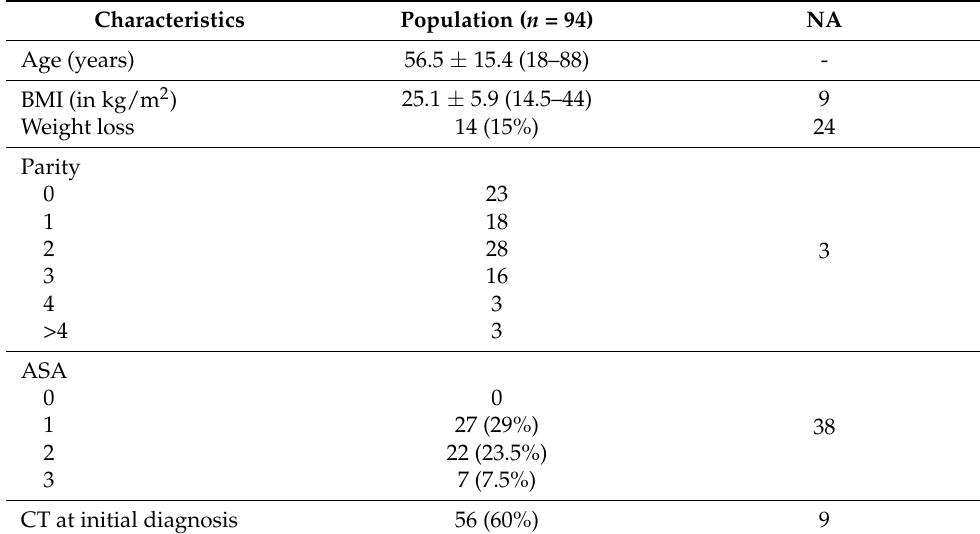
Table 1. Demographic characteristics of the population ( n =